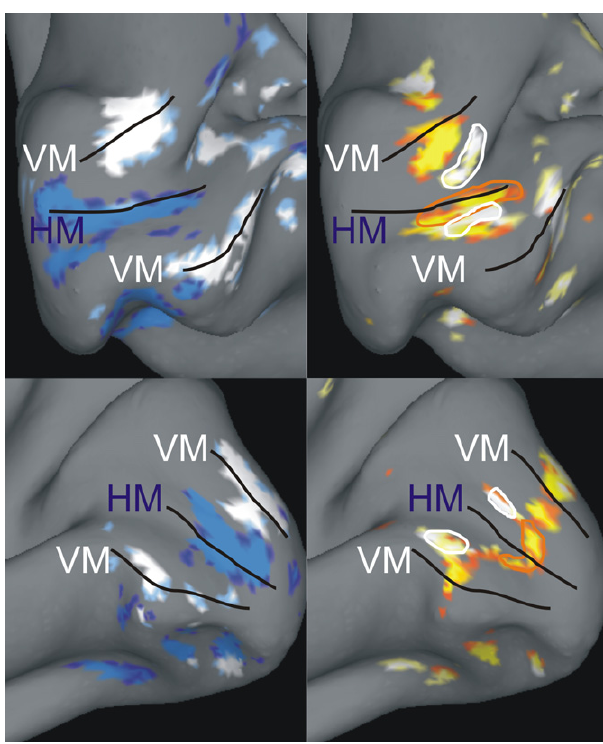
Figure 2. Examples of individual z -maps projected onto infl ated ana- tomical surfaces. The fi gures depict a medial view upon the infl ated calcarine sulcus within the right and left hemisphere of subject #1 (upper row) and #2 (lower row), respectively. The left column shows an overlay of the two z-maps capturing the contrast between horizontal (blue) and vertical (white) meridian stimulations vs. baseline (5.0 < z < 7.0). The right column shows the z-maps capturing the contrasts between contours (red-yellow) and inducers (yellow- white) vs. baseline (3.0 < z < 5.0). In addition, white outlines are drawn around the inducer ROIs and red outlines are drawn around the corresponding contour ROIs. Black lines mark the horizontal (HM) and vertical (VM) meridian map- pings with the VM meridian demarcating the dorsal and ventral V1-V2 border. One can see that there are additional regions responsive to the contours which coincide with the vertical meridian representation. These are the responses to the upper and lower horizontal contours, which crossed the vertical